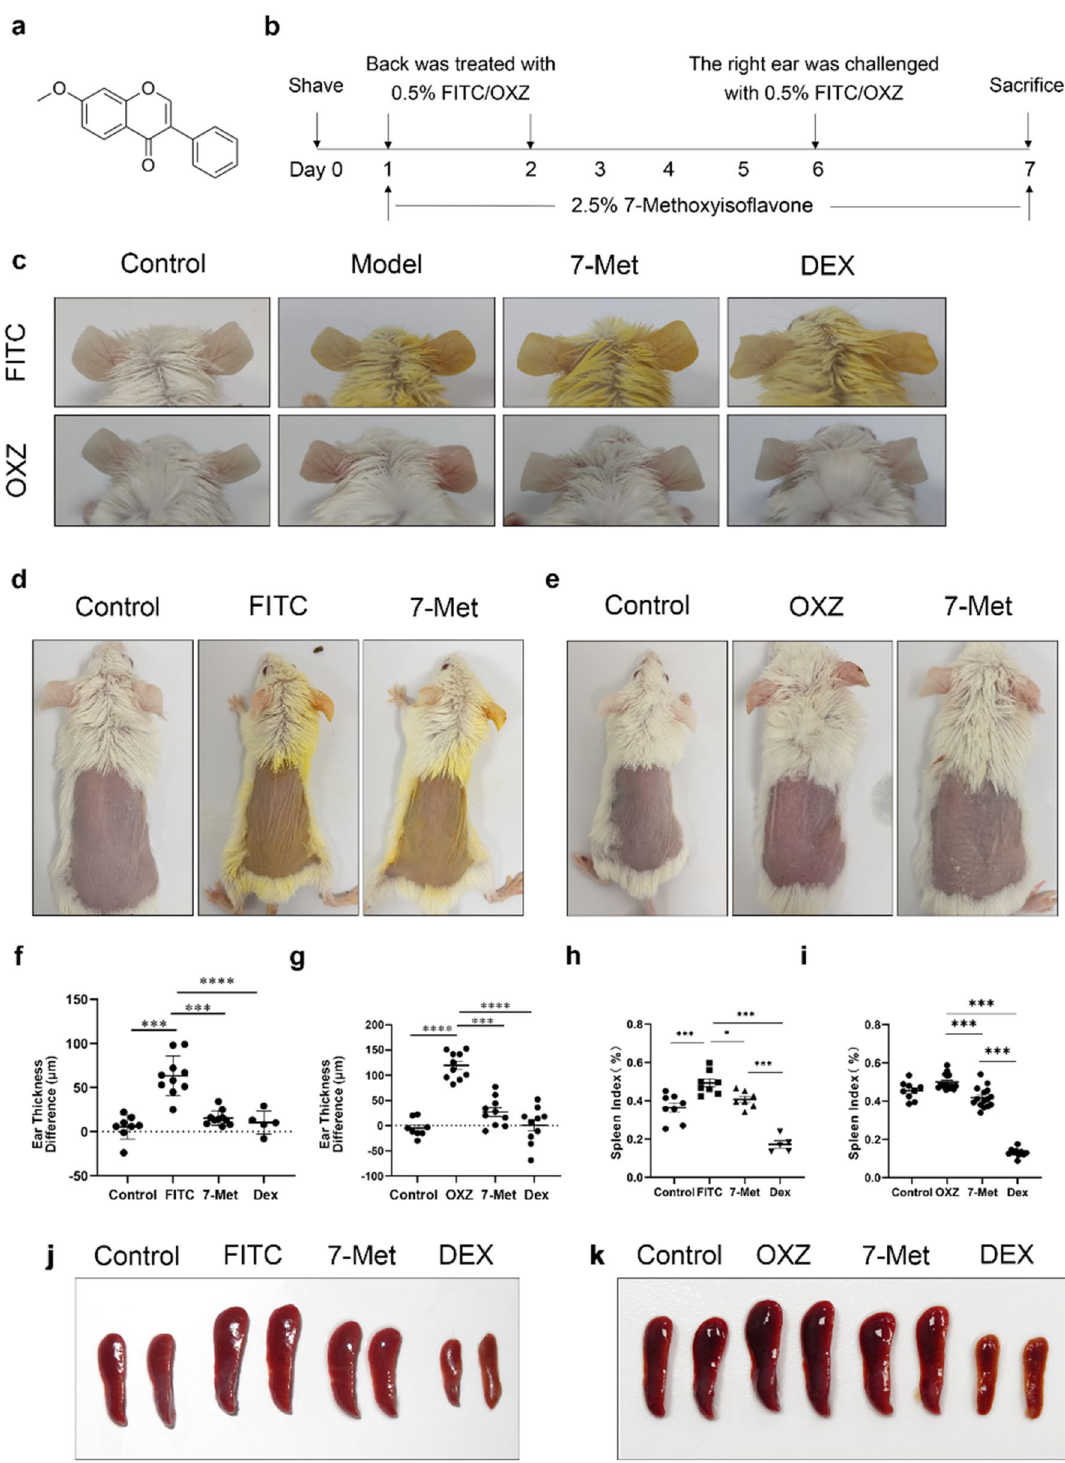
Figure 1. Experimental design and therapeutic effect of 7-Methoxyisoflavone in AD mice. ( a ) Structure of 7-Methoxyisoflavone (7-Met). ( b ) Experimental design for the induction of Atopic dermatitis (AD). ( c ) Clinical features of the ears appearance are shown. ( d ) Whole-body photos of atopic dermatitis mice induced by FITC. (These photos were taken by Yuanyuan Hao and Hongfa Qian). ( e ) Whole-body photos of atopic dermatitis mice induced by OXZ (These photos were taken by Yuanyuan Hao and Hongfa Qian). ( f ) Effect of the 7-Met on ear thickness induced by FITC. (p FITC < 0.0001, p 7-Met < 0.0001, p DEX < 0.0001, one-way ANOVA). ( g ) Effect of the 7-Met on ear thickness induced by OXZ. (p OXZ < 0.0001, p 7-Met < 0.0001, p DEX < 0.0001, one-way ANOVA). ( h ) Effect of the 7-Met on spleen index induced by FITC. The spleen index of mice treated with 7-Met was as significantly reduced (p = 0.0083, two- tailed). ( i ) Effect of the 7-Met on spleen index induced by OXZ. The spleen index of mice treated with 7-Met was as significantly reduced (p < 0.0001, one-way ANOVA). ( j ) Clinical features of spleens induced by FITC. ( k ) Clinical features of spleens induced by OXZ. Values are expressed as the means ± S.E.M. (n = 5–10). *p < 0.05, **p < 0.01, ***p < 0.001 and ****p < 0.0001. FITC fluorescein isothiocyanate, OXZ oxazolone, 7-Met 7-Methoxyisoflavone, DEX